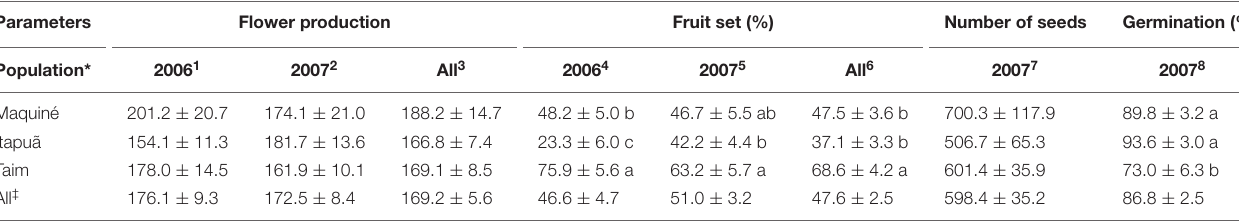
TABLE 3 | Fertility parameters, including mean number of seeds per fruit, germination rate ( n = 30 seeds per fruit), mean number of flowers per plant, and fruit set of Vriesea gigantea , in the three studied populations and the 2 years evaluated. Parameters Flower production Fruit set (%) Number of seeds Germination (%)